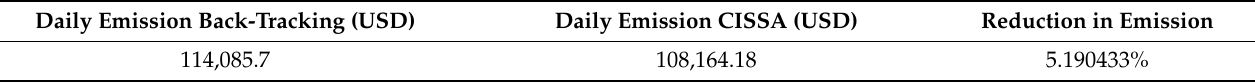
Table 31. Total daily emissions comparison—case study